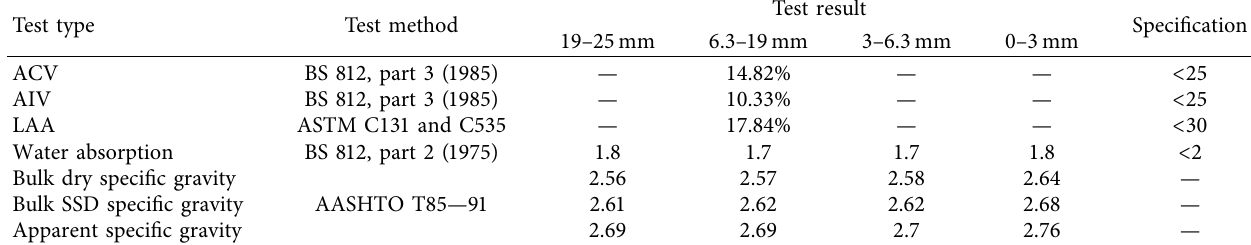
Table 2: Properties of aggregate materials.